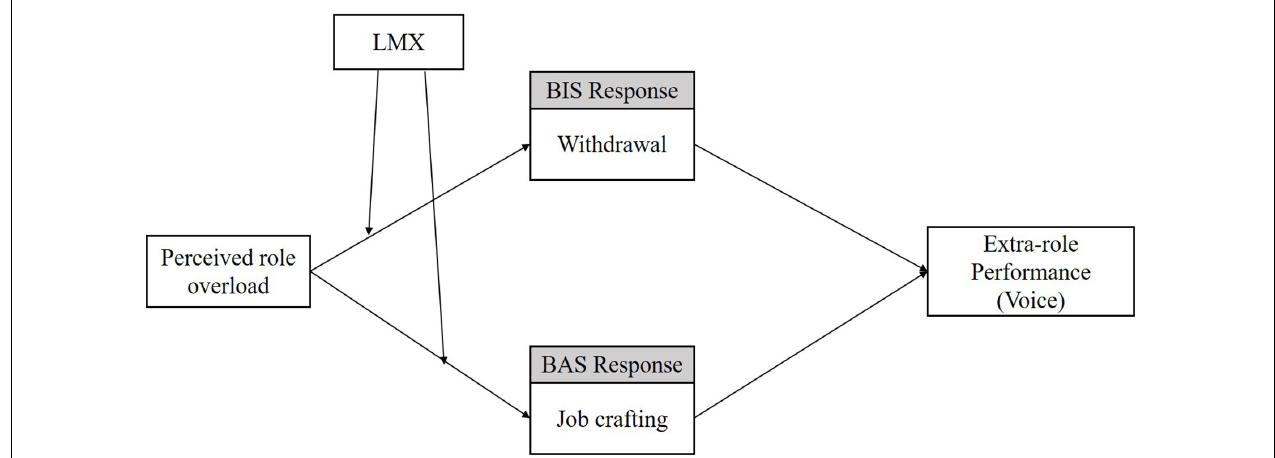
FIGURE 1 | Theoretical model of the current